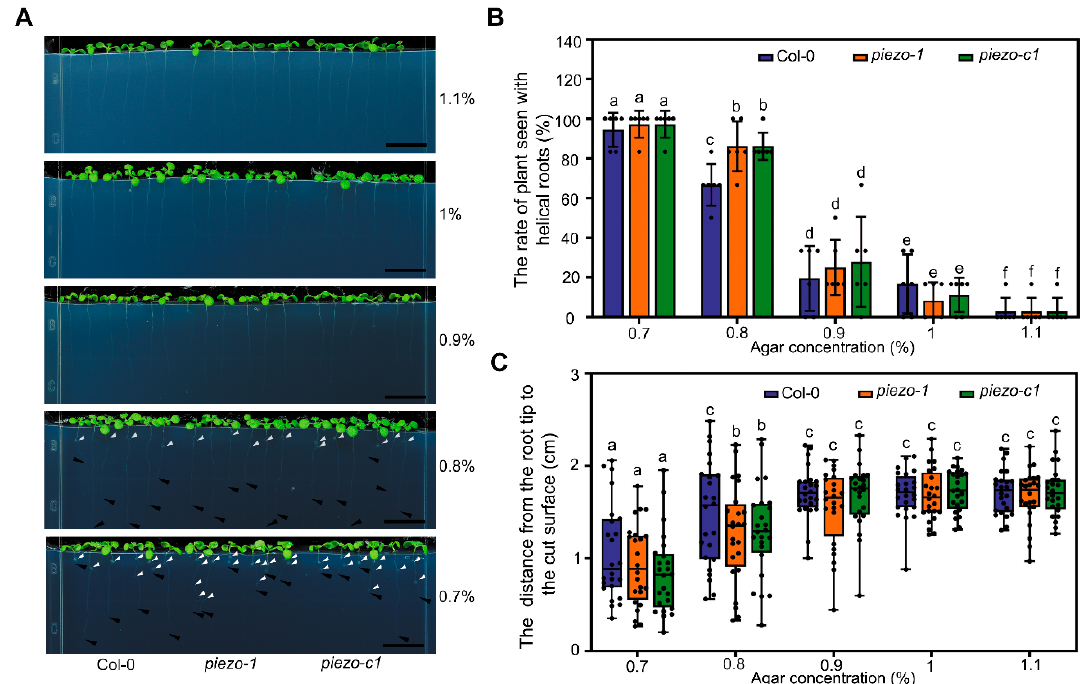
Figure 4. The atpiezo mutant plants show altered growth status inside the medium. ( A ) Representative images of growth status of primary roots of 7-day-old plants in the agar medium. White solid arrows indicate the helixes at primary roots. Black solid arrows indicate the positions where the root tips reach. Bar = 1 cm. ( B ) The rate of helical roots of WT and atpiezo mutants in the media with different agar concentrations. Data are presented as mean ± SD ( n = 6 plates, more than 10 seedlings in each plate) and analyzed with two-way ANOVA and Tukey’s multiple comparison test (Different lowercase letters indicate significant differences at p < 0.05). ( C ) The distance from the root tip to the medium surface of WT and atpiezo mutants in the media with different agar concentrations. Boxplots span the first to the third quartiles of the data. A line in the box represents the median ( n > 20). The results were analyzed with two-way ANOVA and Tukey’s multiple comparison test (Different lowercase letters indicate significant differences at p < 0.05).